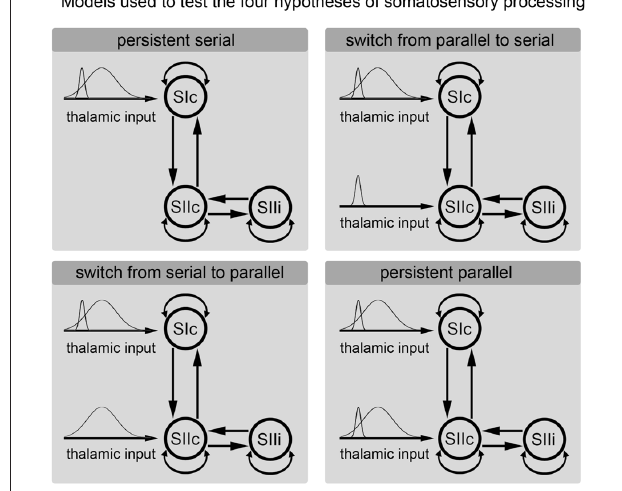
FIGURE 3 | Hypotheses regarding the processing of somatosensory information. Each of the subfigures shows a model of the corresponding tested hypothesis. The extrinsic input functions of the model are shown to the left of each subfigure. The inputs correspond to stimulus functions encoding the tactile stimuli. These input functions are required by the implementation of the dynamic causal modeling (DCM) representing the thalamic input caused by the stimulus. Dependent on the model, these inputs are forwarded only to the primary somatosensory cortex (SI) or to both the SI and